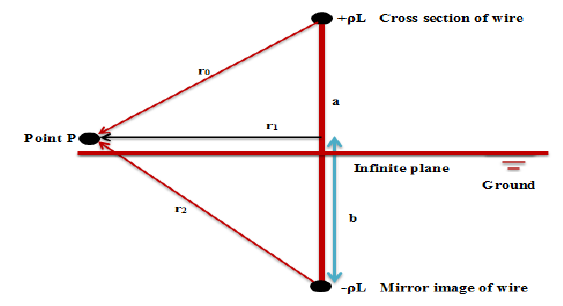
Fig. 4. Mirror image of a wire and infinite plane.